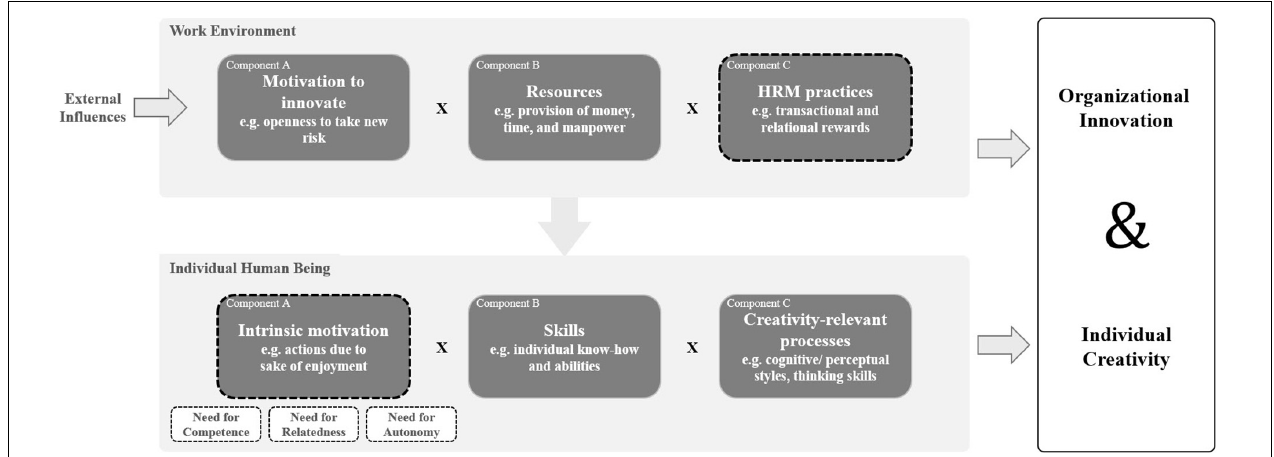
FIGURE 1 | Modified componential model of creativity and innovation in organizations adapted from Amabile and Pratt